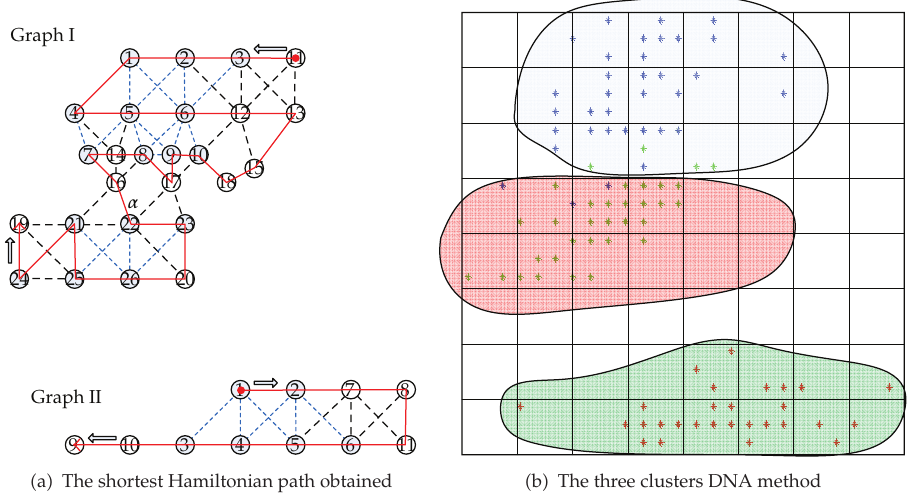
Figure 15: A short Hamiltonian path for the induced